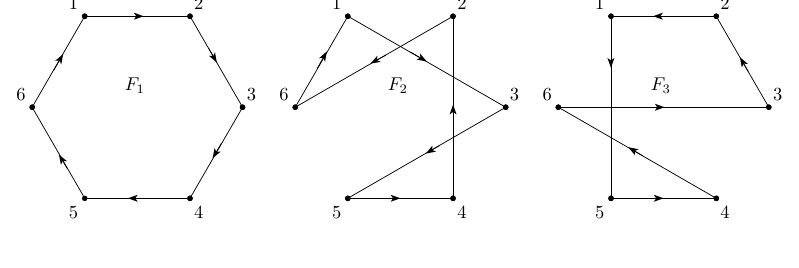
Fig. 3: The digraphs F 1 , F 2 and F 3 .